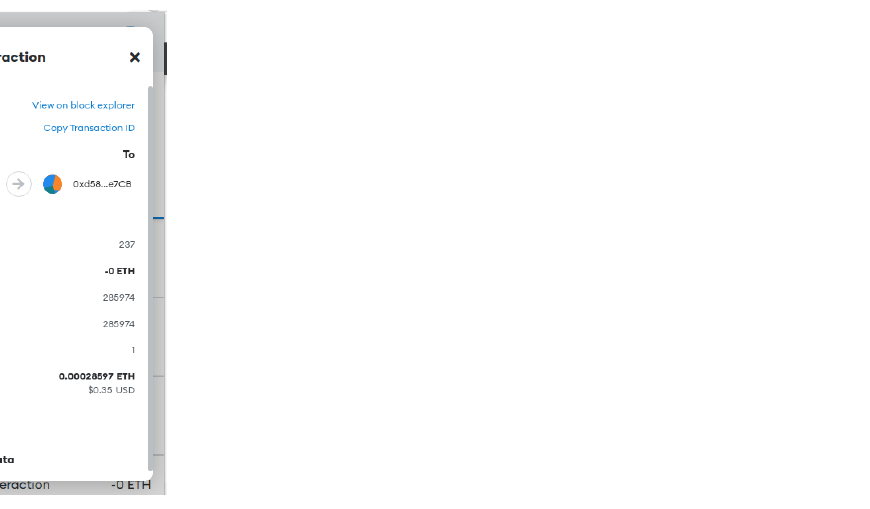
Figure 10. Screen capture of DAPP asset register transaction log entry in MetaMask showing the final cost of registering a new asset.